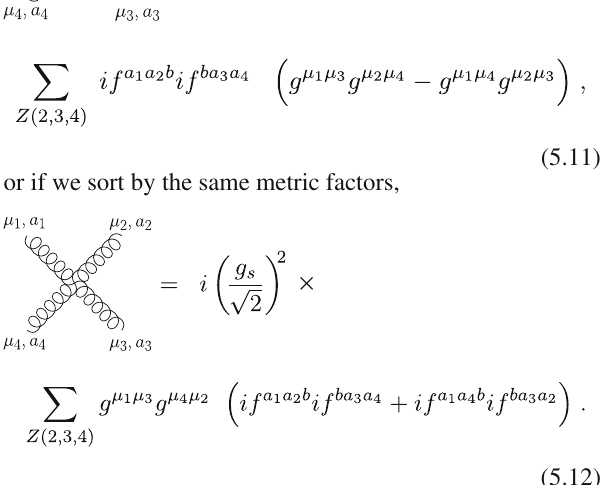
Translating to the chirality-flow picture, using the conven- tionalgraphicalrepresentationforthecolorstructure,wenote